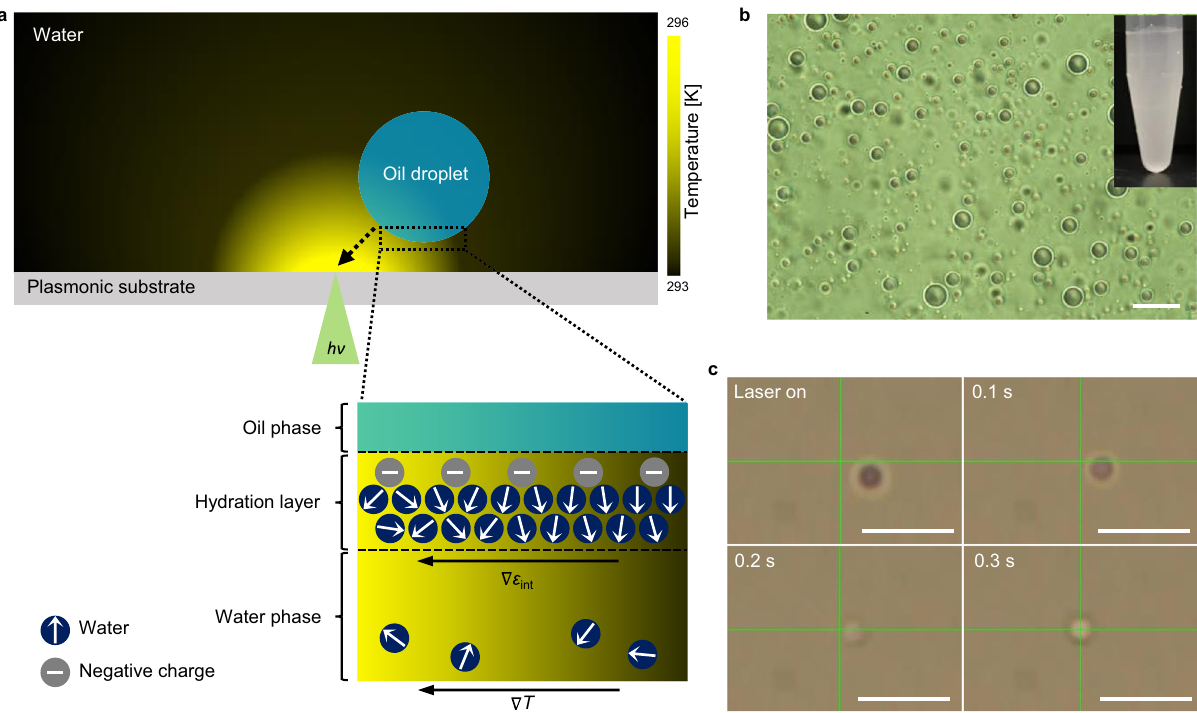
Fig. 1 Working principle of OTTs and trapping of a PFP droplet. a A temperature gradient is created by the photothermal conversion of light at a plasmonic substrate, and a water-dispersed oil droplet migrates to a hot region. Water molecules and negative charges are arranged at the water/oil interface, having a radial orientation of water dipoles (indicated by arrows). The temperature gradient ( ∇ T = d T/ d r, r : distance from the laser beam) induces a permittivity gradient ( ∇ ε int ) along the interfacial water layer by thermal perturbation of interfacial water ordering, leading to a thermophoretic migration of the droplet toward the hot region. b Optical image of PFP droplets dispersed in water (scale bar: 10 μ m). Inset is a photograph of PFP-in-water emulsions. c Optical images of a PFP droplet under an optical input in the course of time (scale bars: 10 μ m). Crossbars indicate the position of the laser beam. The droplet is trapped once it is close to the laser